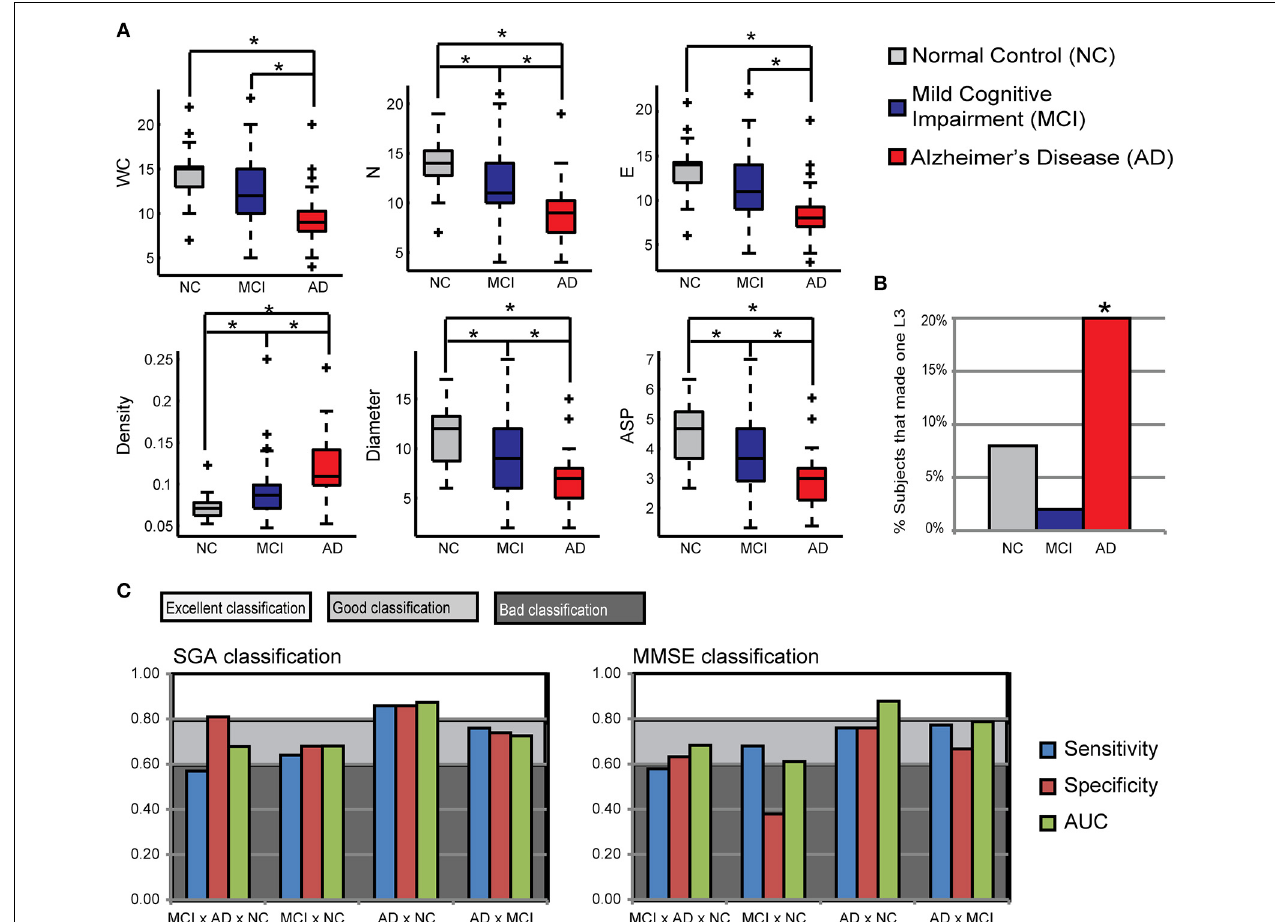
FIGURE 2 | Speech Graph Attributes (SGA) differentiates psychopathological groups. (A) SGA boxplots with significant differences among Alzheimer Disorder (AD), Moderate Cognitive Impairment (MCI) and control groups ( N = 25 on AD and C group, N = 50 on MCI group; Kruskal-Wallis test followed by two-sided Wilcoxon Rank-sum test with Bonferroni correction with alpha = 0.0167). (B) Percentage of subjects in each group that made one L3 on the verbal fluency test. AD subjects showed